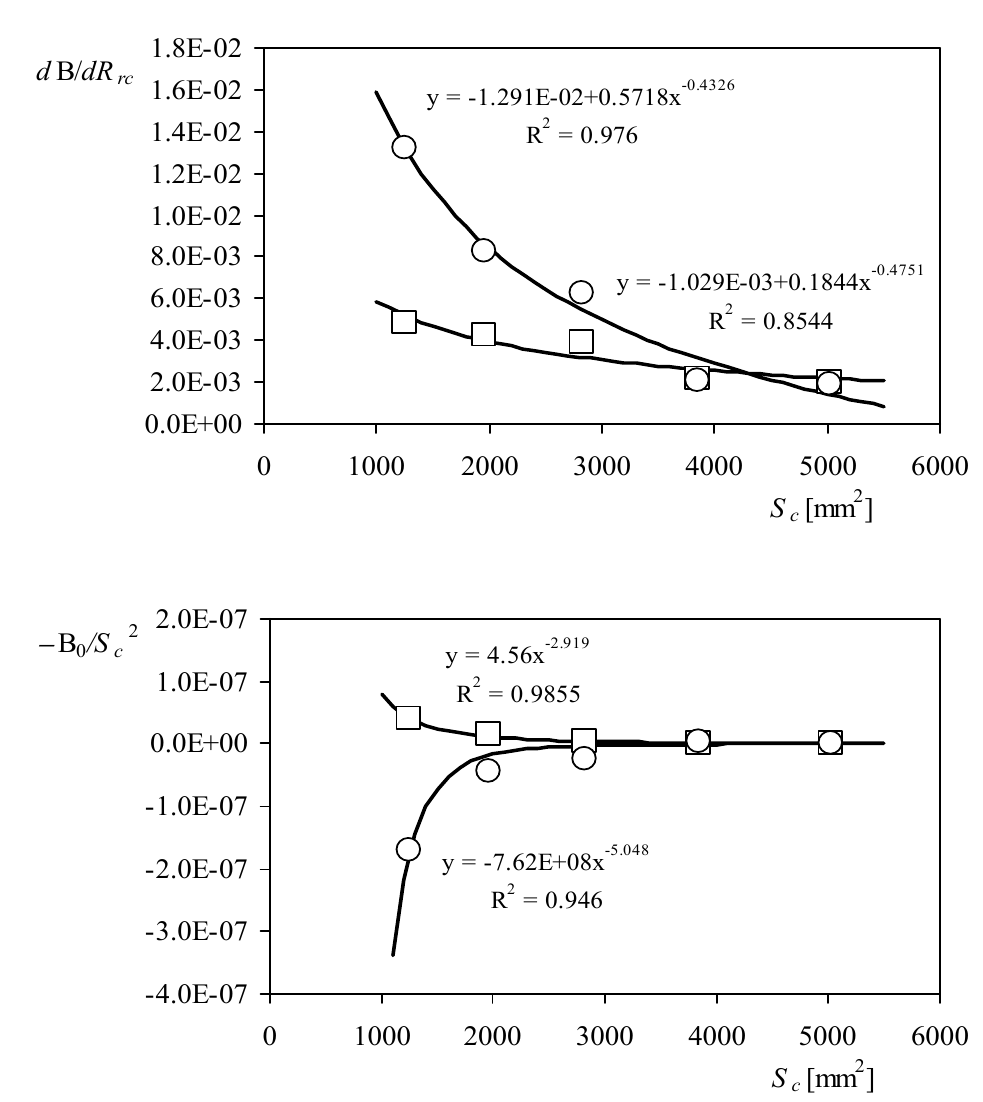
Figure 12. Slope and offset (divided by the squared front area of the cups) of the linear fittings from Table 3, as a function of the cups’ front area, S Climatronics 100075 (squares) and the Ornytion 107A (circles) anemometers. Power fittings have also been added to the